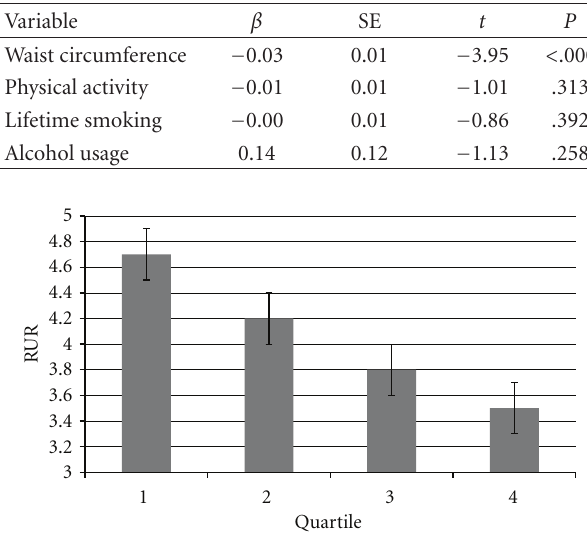
Figure 1: Mean relative uptake ratio (RUR) as a function of waist circumference split into quartiles, with standard error bars, adjusting for covariates, smoking, physical activity, and alcohol